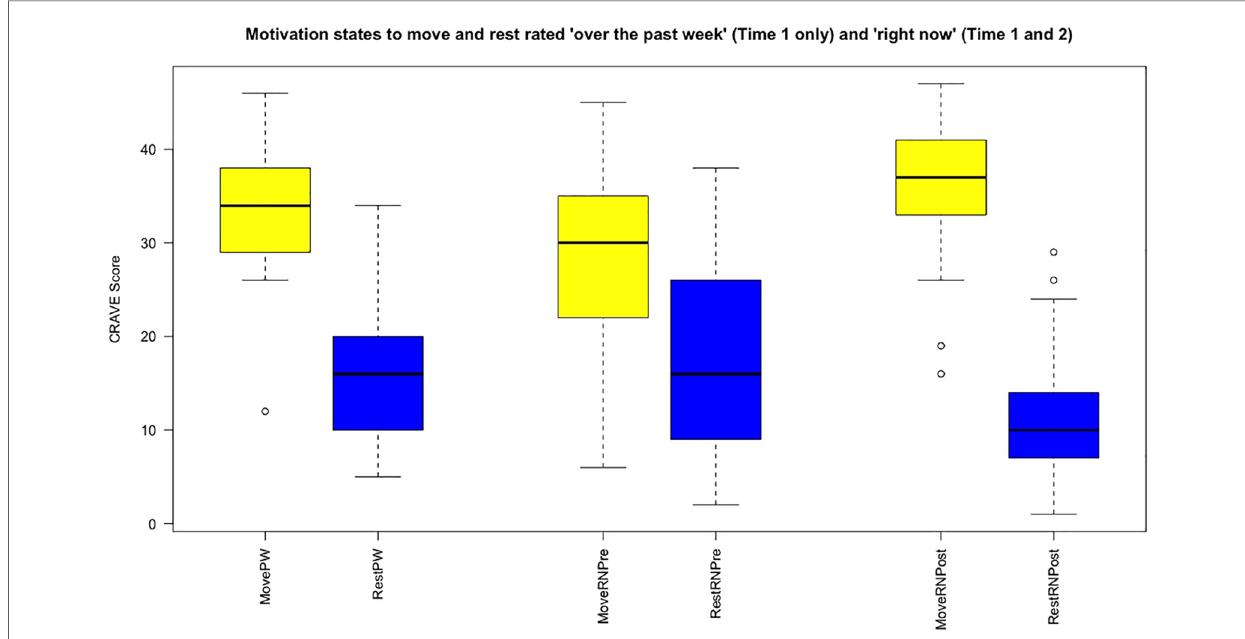
FIGURE 1 Motivation states to move and rest rated “ over the past week ” (PW, pre only) and “ right now ” (RN, pre and